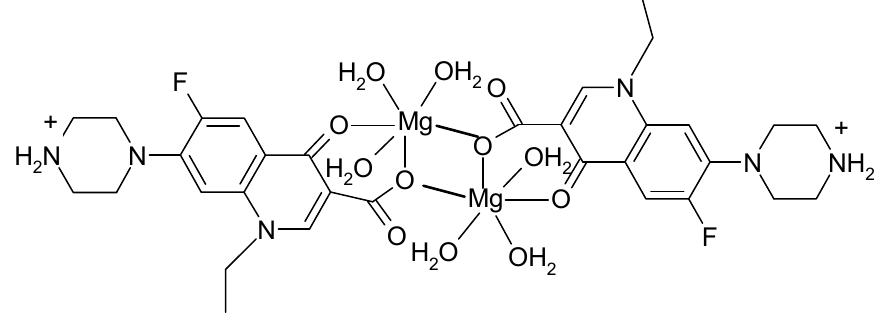
Figure 12. Structure of the dimeric complex [Mg from